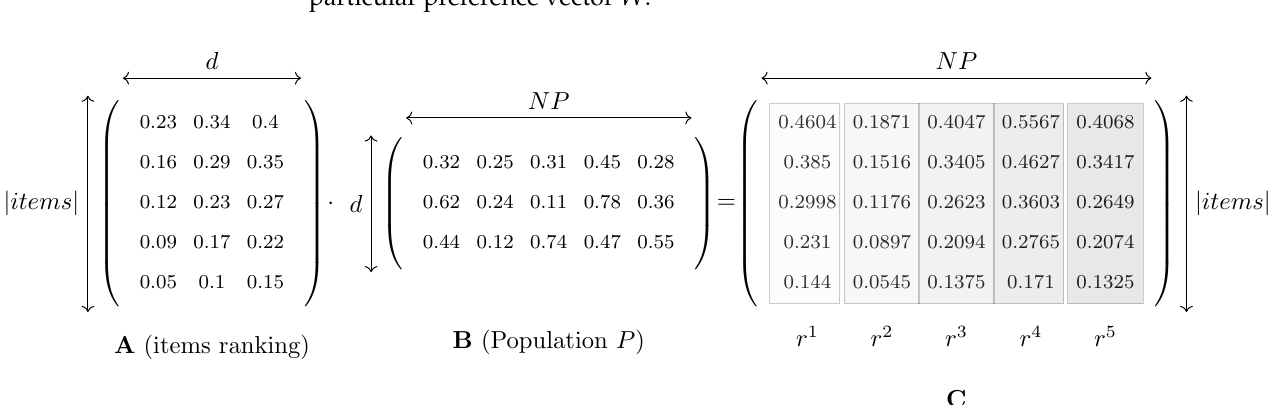
I and some population P (real value vectors) of the ∈ 1,2, . . . , NP ∈ { }